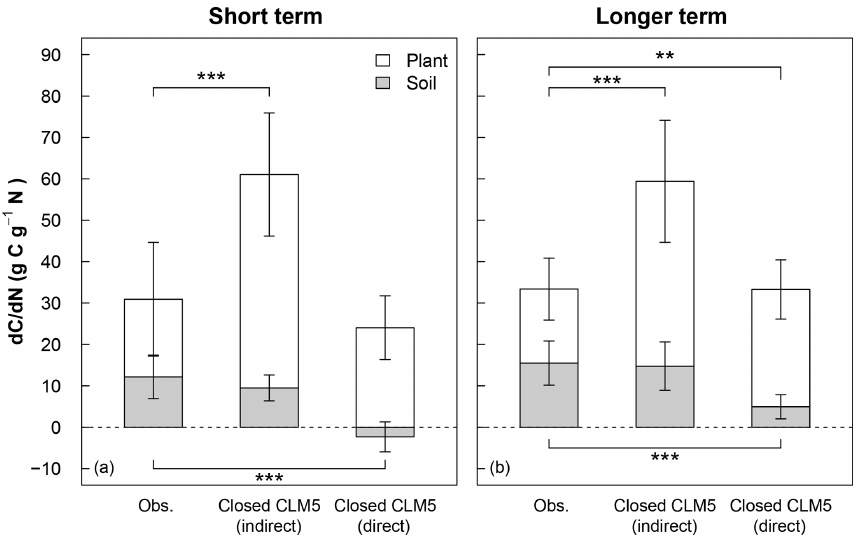
Figure 4. Mean short-term ( < 3 years) and longer-term ( > 3 years) response of C stocks to added N (dC / dN) estimated from 15 N experiments (Obs) and model simulations using a closed N cycle (Closed CLM5). The dC / dN for field experiments (leftmost bars in a and b ) is calculated by multiplying the site-level 15 N recovery for foliage, wood, bark, fine roots, coarse roots, O horizon, and mineral soil horizon by the C : N ratio for each pool (Eq. 3; see Table S3 for C : N ratios) and then averaging the total plant or total soil dC / dN across sites. For equivalent comparison to observations, model dC / dN (center bars in a and b ) is calculated indirectly using observational C : N ratios (indirect) and Eq. (3), as well as directly from the model using the model’s C : N ratios (direct) according to Eq. (2) (rightmost bars in a and b ). For plant dC / dN, data from Gårdsjön, Aber low, and Aber high experiments were not included because sub-pools from plants were not reported. For soil dC / dN, data from Gårdsjön and Bear Brook fertilized were not included because sub-pools from soils were not reported. Error bars represent 1 standard deviation. Variation in the observations occurs from differences in N recoveries and C : N ratios measured across plant and soil sub-pools and sites. Variation in the indirect model estimates occurs from differences in N recoveries estimated by CLM5 across modeled sites and from variation in measured C : N ratios. Variation in the direct model estimates occurs from differences in CLM5’s stocks and C : N ratios across modeled sites. Statistical differences between observations and model estimates of dC / dN are indicated with asterisks for plants (above the white bars) and for soils (below the gray bars), where ∗∗ represents p < 0 . 01 and ∗∗∗ represents p < 0 .